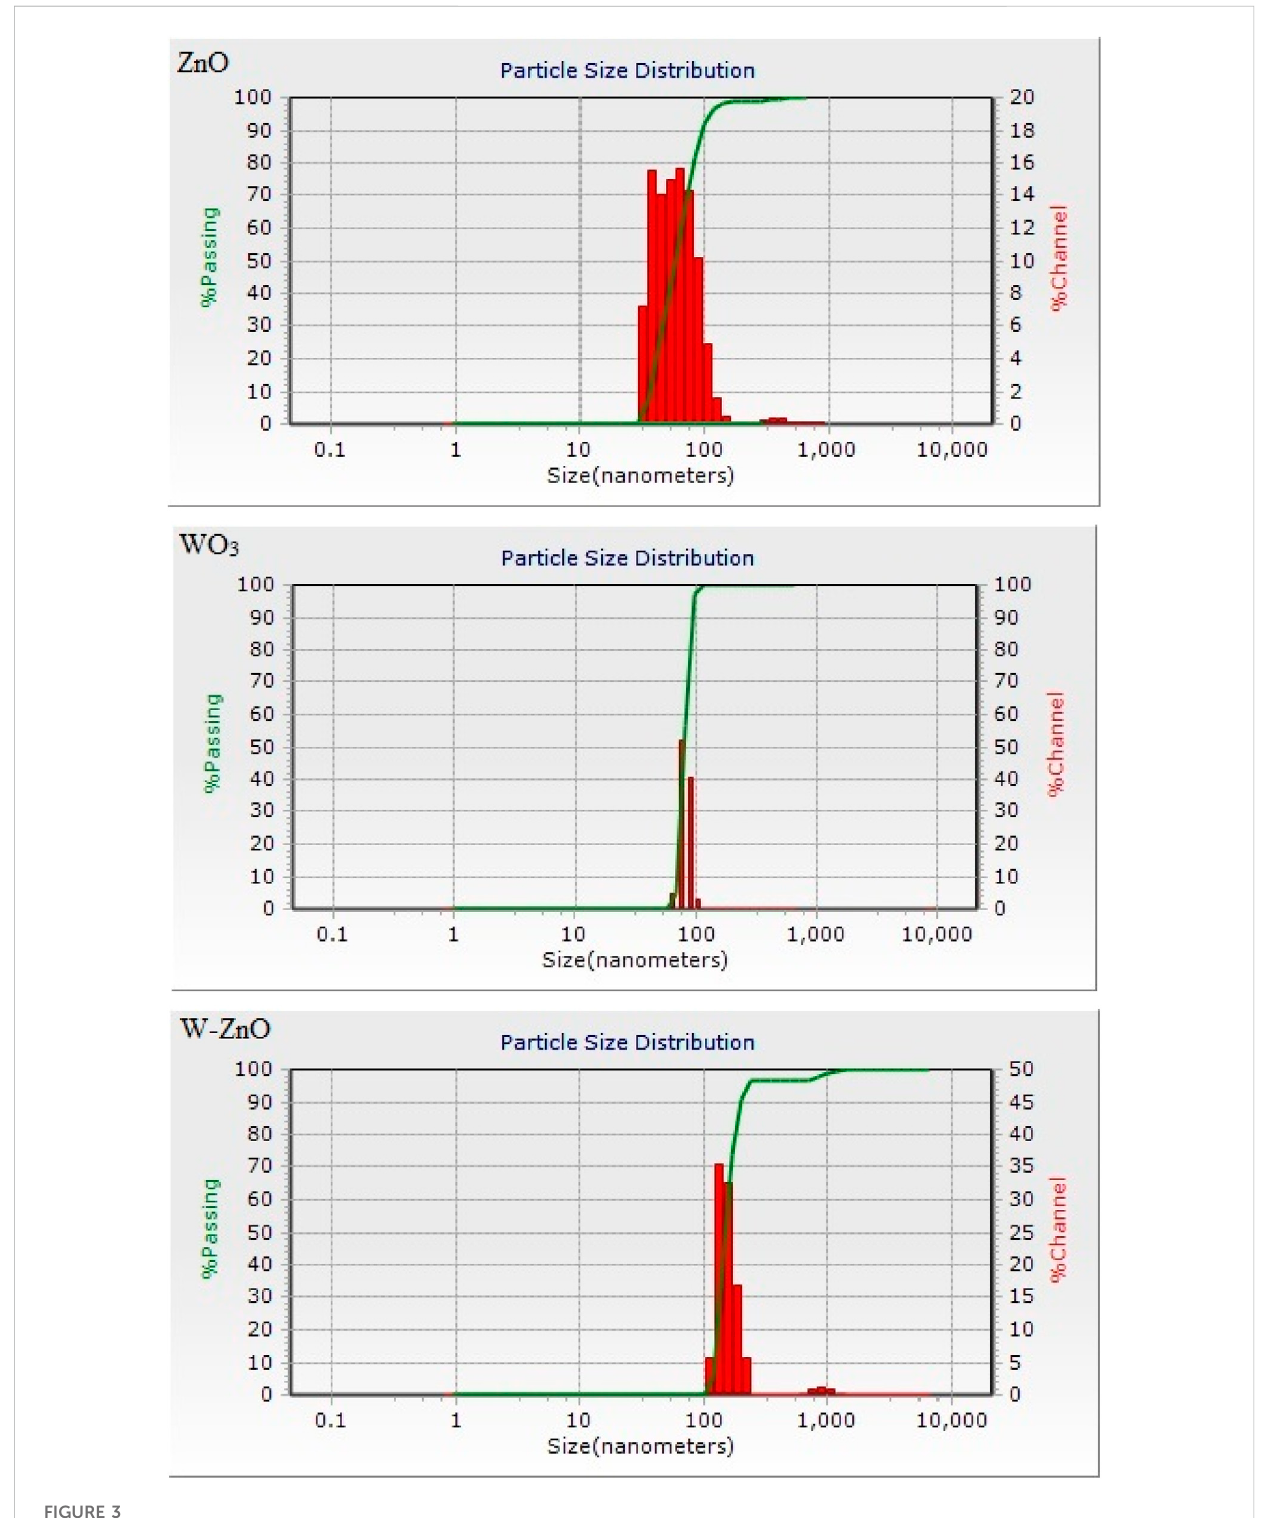
FIGURE 3 The size distribution charts of ZnO, WO 3 and W-ZnO